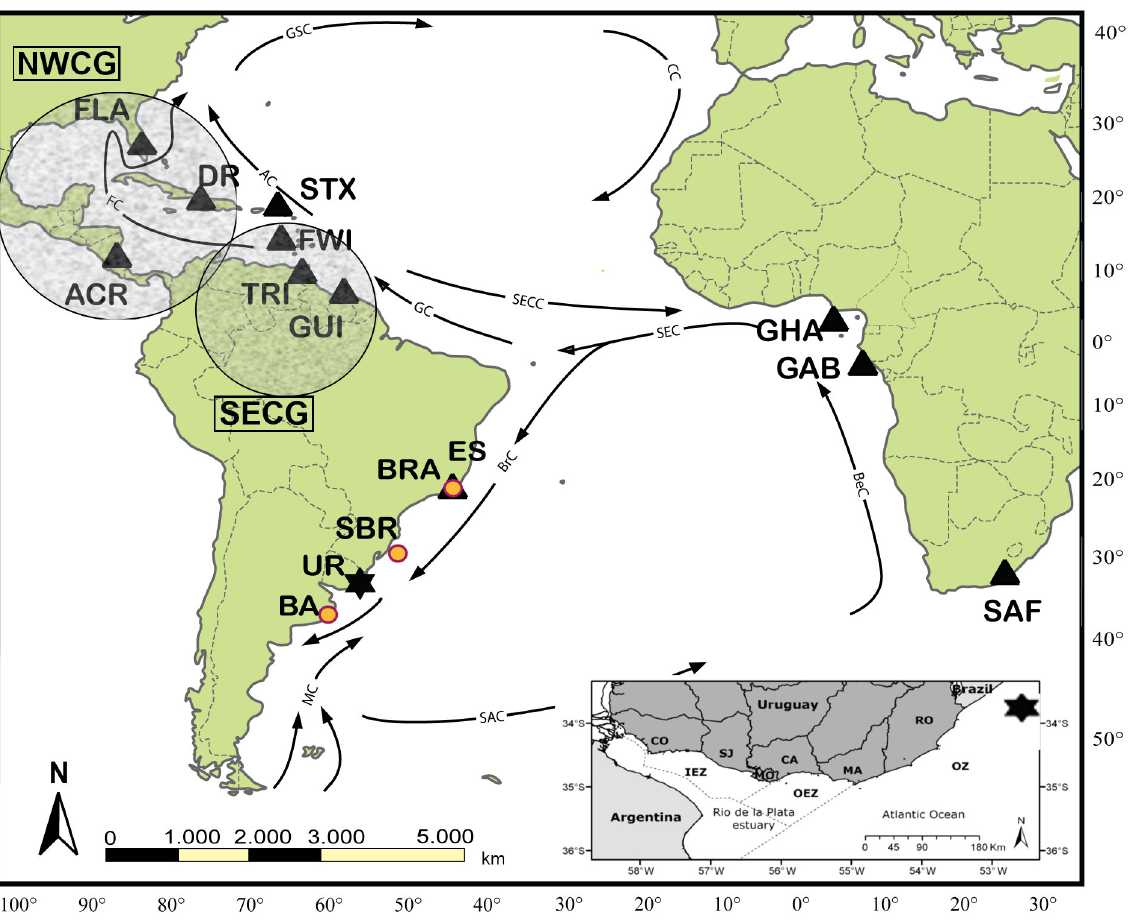
Figure 1. Map indicating the location of the Uruguay (UR) foraging ground (black star) relative to the main Atlantic leatherback nesting colonies (black triangles); BRA (Espirito Santo, Brazil); TRI (Trinidad), GUI (French Guiana and Suriname) and FWI (French West Indies including, Guadaloupe and Martinique), which represent the SECG group; FLA (Florida), DR (Dominican Republic), and ACR (Costa Rica), which represent the NWCG group; STX (St. Croix), GHA (Ghana), GAB (Gabon), and SAF (South Africa). Additional foraging ground sites (yellow circle): Esp í rito Santo State (ES, Brazil), SBR (Southern Brazil), and BA (Buenos Aires, Argentina) are indicated (yellow circles). Arrows represent oceanic currents: Gulf Stream (GSC), Antilles (AC), Florida (FC), South Equatorial Current (SEC), South Equatorial Counter Current (SECC), Guiana Current (GC), Brazil Current (BrC), Malvinas Current (MC), South Atlantic Current (SAC), and Benguela Current (BeC). The inset shows the Uruguayan coast. The coastal waters could be divided into three regions: Inner Estuarine Zone (IEZ), Outer Estuarine Zone (OEZ), and Oceanic Zone (OZ), which are shown as well as the Departments (CO: Colonia, SJ: San Jos é , MO: Montevideo, CA: Canelones, MA: Maldonado; RO: